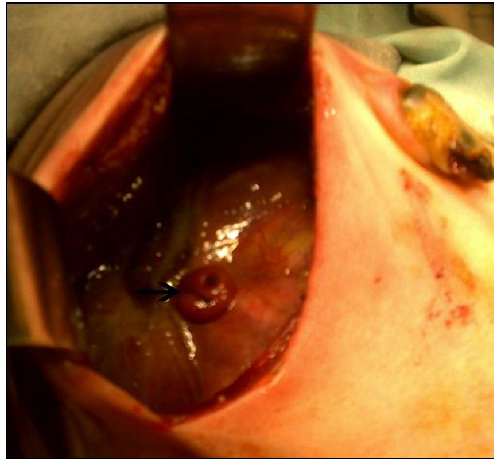
Figure 3: perforated ileum pouting like a stoma.